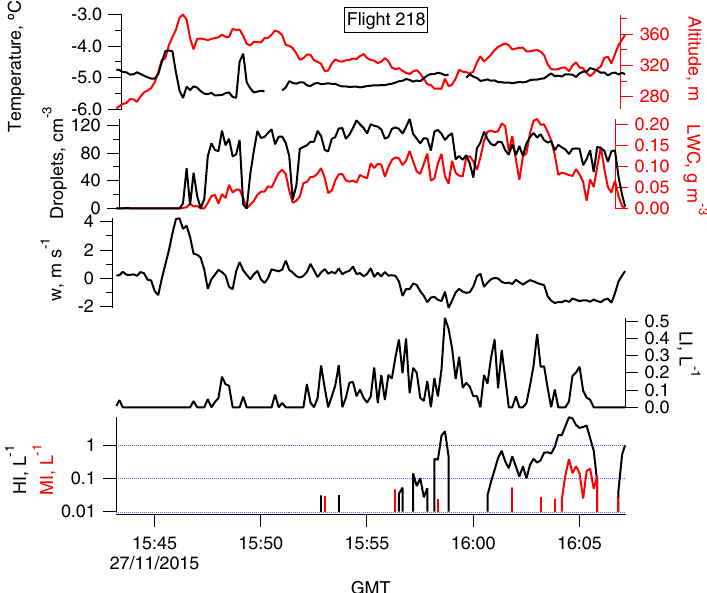
Figure 7. Time series of microphysical parameters during a constant altitude run at − 5 ◦ C (400m) during Flight 218.